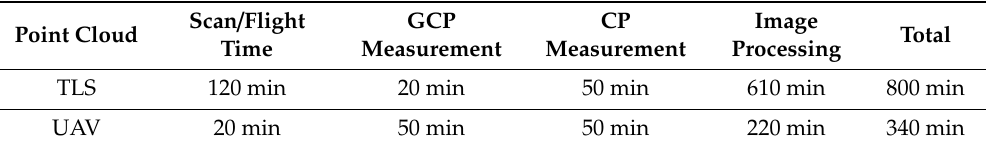
Table 3. Time requirements for TLS- and UAV-based point cloud generation. Point Cloud